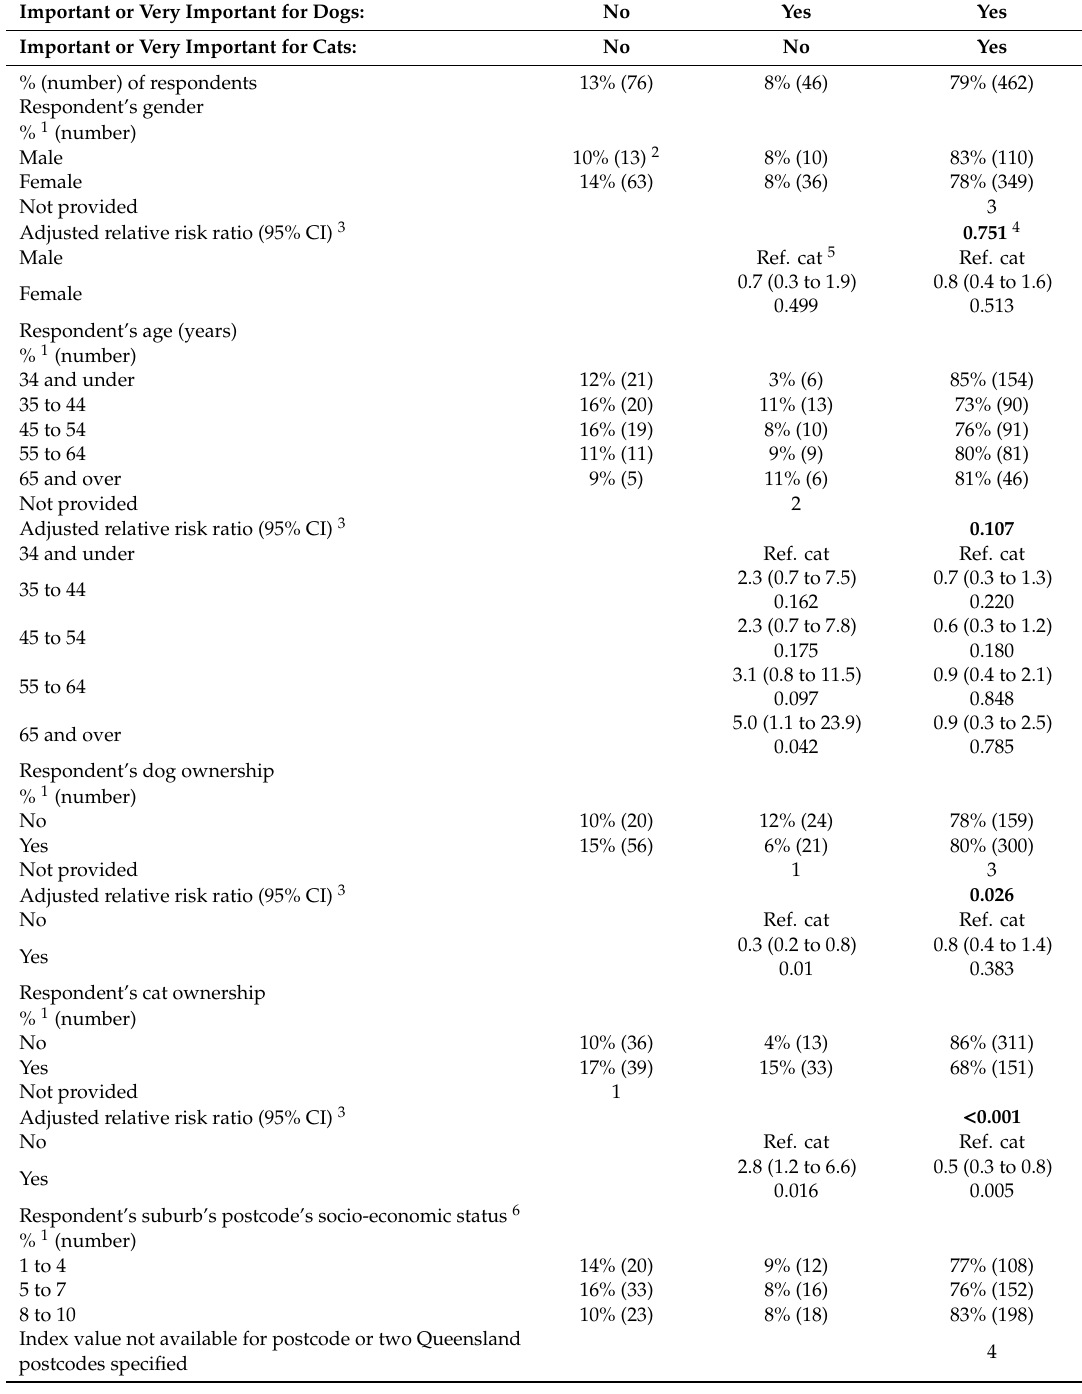
Table 9. Associations between socio-demographic variables (independent variables) and respondents’ collective views about the importance of compulsory registration of dogs and cats by local councils for controlling domestic (owned) dog and cats (the response or dependent variable). Each respondent was classified into one of three dependent variable categories: important or very important for dogs (yes or no) and important or very important for cats (yes or no) ( n =